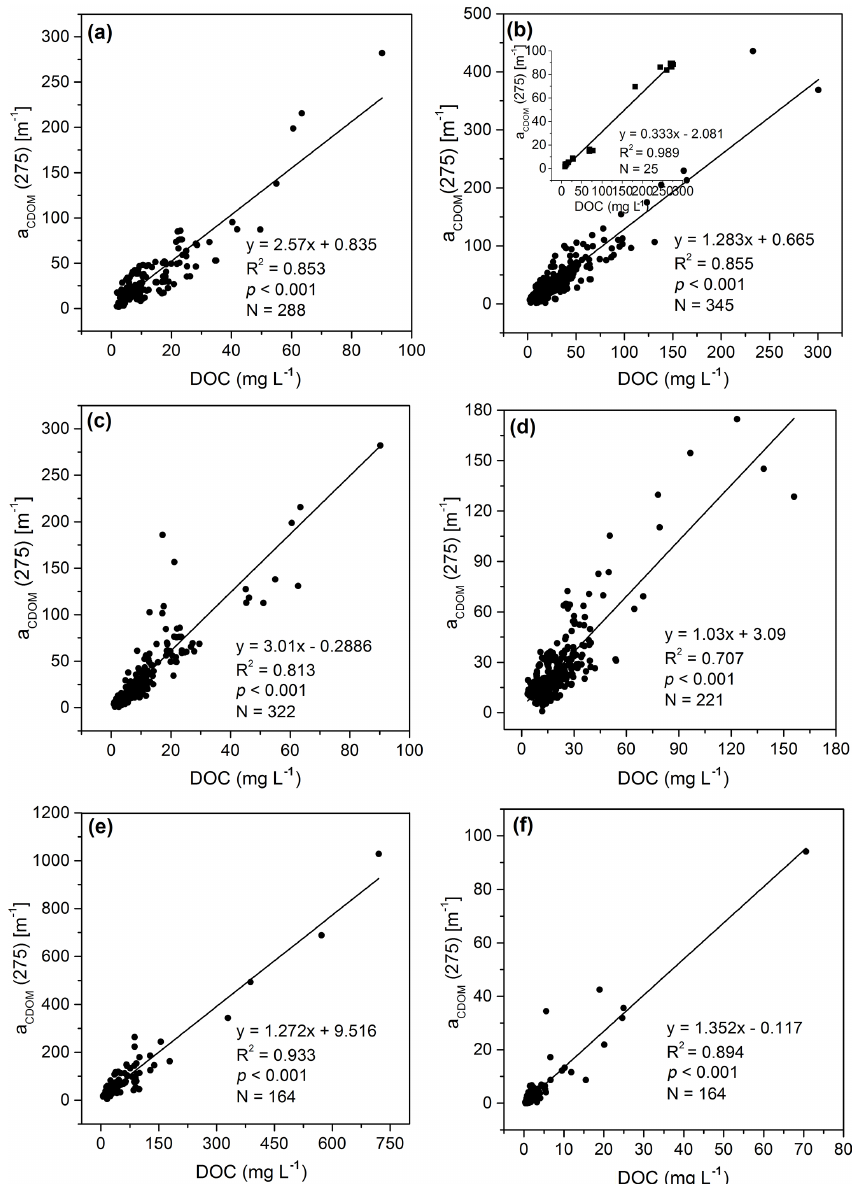
Figure 3. Relationships between DOC and a CDOM (275) in different types of inland waters: (a) fresh water lakes, (b) saline water lakes, (c) river and stream waters, (d) urban waters, (e) ice-covered lake underlying waters, and (f) ice-melting lake waters. The regression metrics without these high DOC concentrations in (b–f) are listed in Table